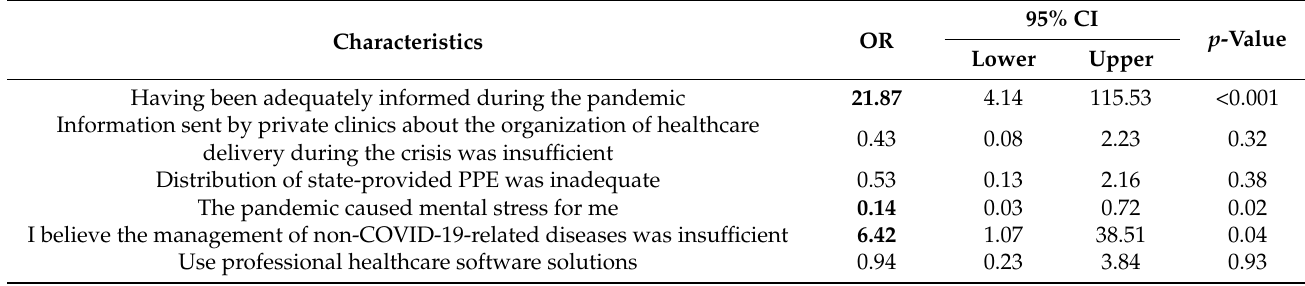
Table 2. Factors associated with overall satisfaction by multivariate logistic regression